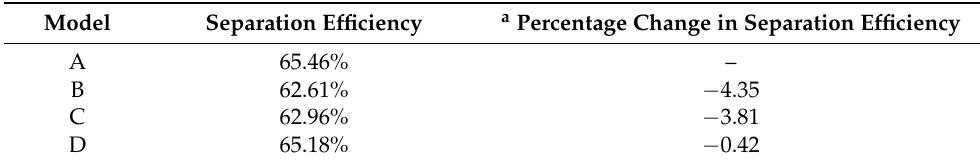
Table 11. Values and percent change in separation efficiency for cyclone models A, B, C, and D.